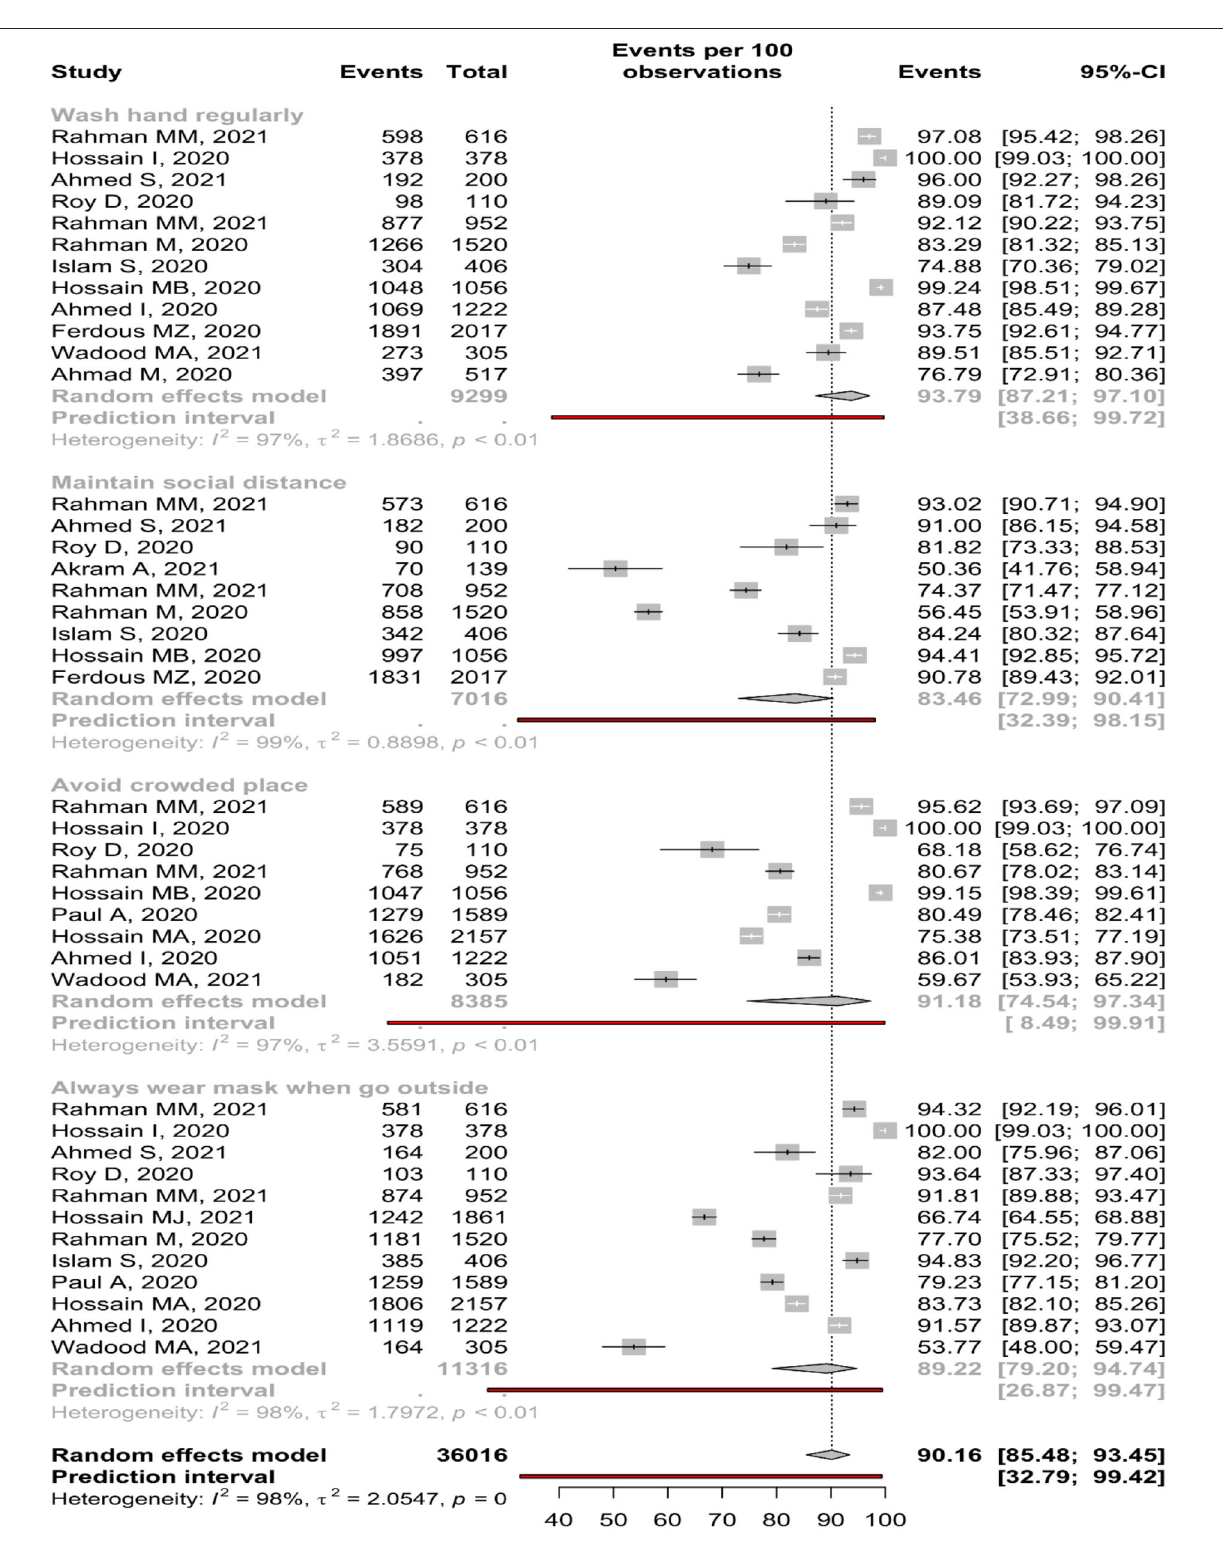
Frontiers in Medicine |